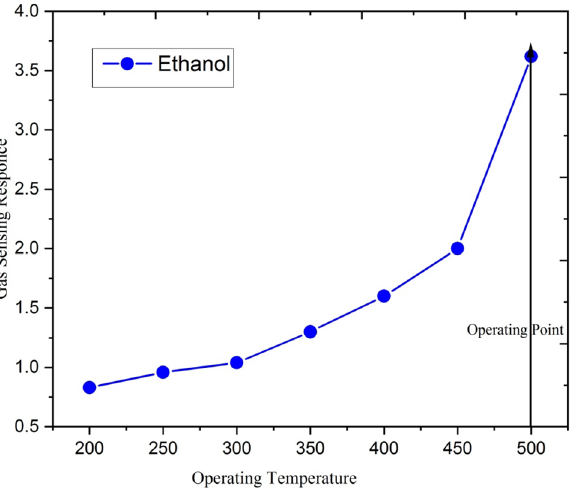
Figure 10. Response of the 5at% Ga-doped ZnO thin film (Ag 9+ ion irradiated at 5 × 10 13 ion fluence) for 250 ppm ethanol concentration at different operating